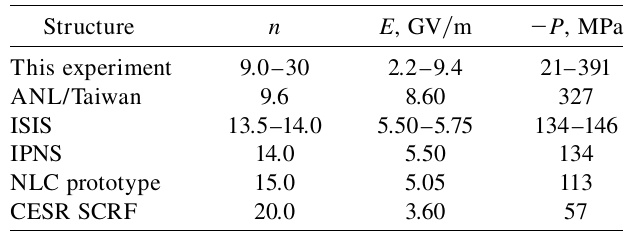
TABLE II. Pressure on emitter surfaces.